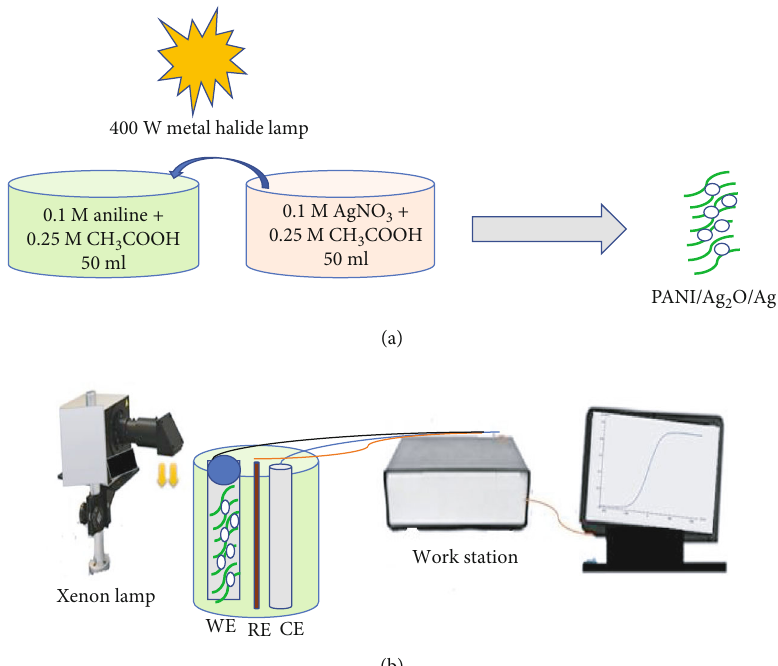
O/Ag composite and (b) the electrochemical system of hydrogen generation through an 2